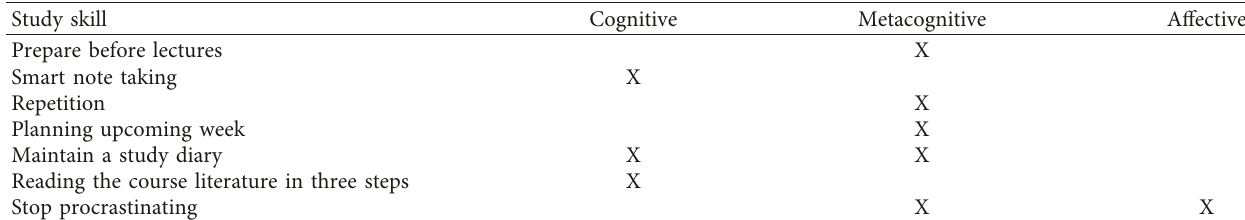
Figure 1: Timeline showing the structure of the study motivation and study skills Table 1: Classification of the study skills in the PIC module.